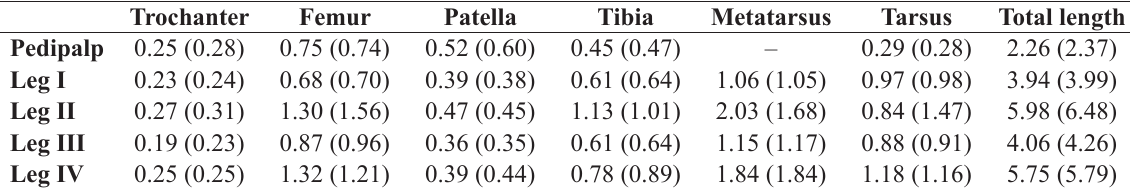
Table 3. Length of appendage-segments in millimeters in N. bidentatum sparsum Gruber & Martens, 1968 from Prosenjakovci, Slovenia: ♂ (♀).